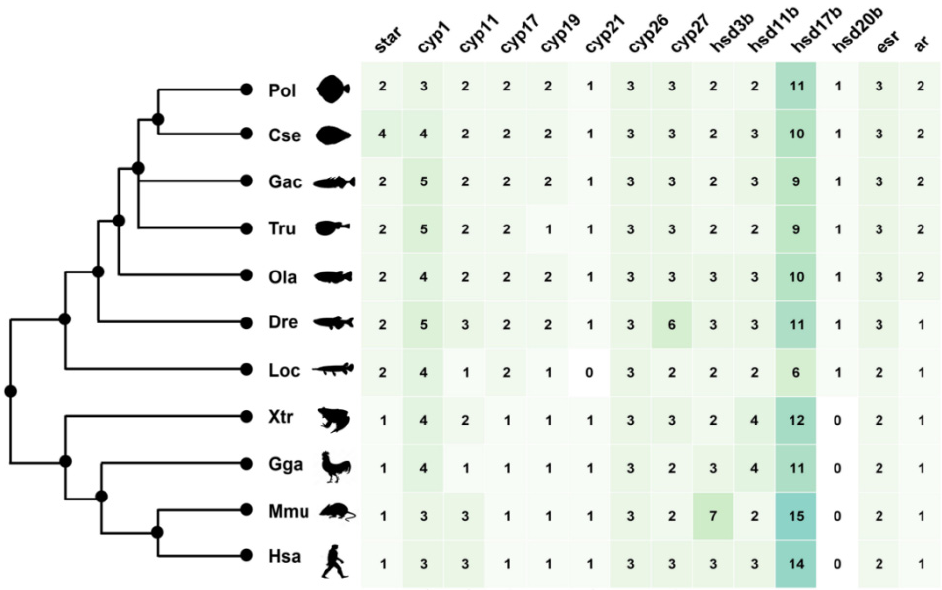
cyp11 , cyp17 , cyp19 , cyp21 , cyp26 and cyp27 families (Figure 2b). The cyp17 clade